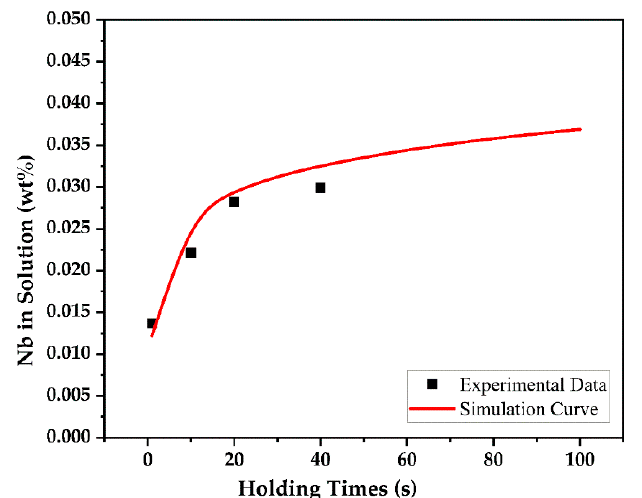
Figure 9. Measured data and calculated data of Nb dissolution behavior in the samples with holding times at 1150 °C.